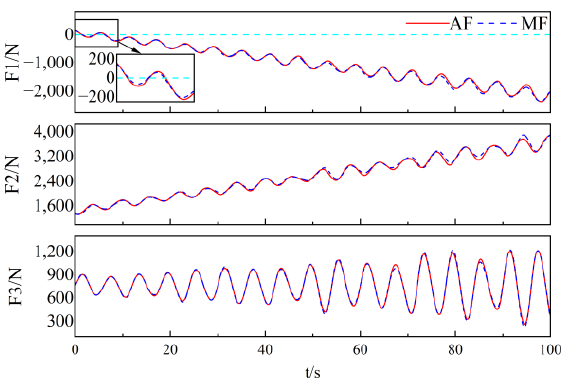
Figure 16. Tractive force of each drive support chain of the stable platform under personnel mass of 100 kg.